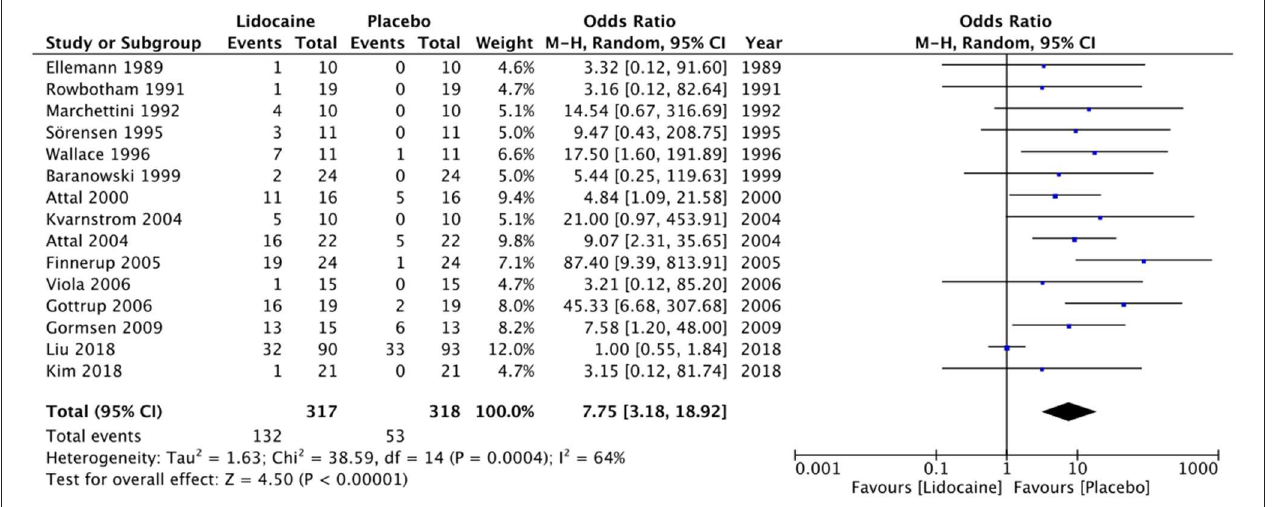
FIGURE 5 | Forrest plot of adverse events with IV lidocaine vs.